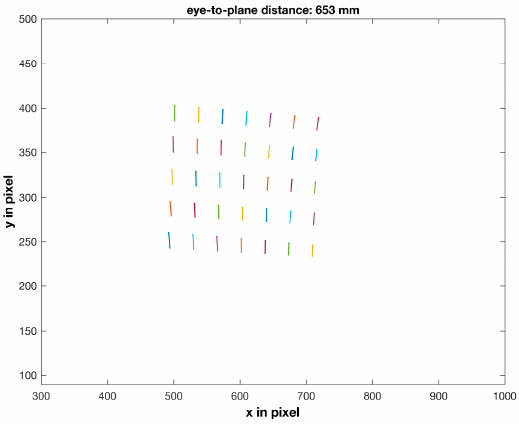
Figure A10. Map of disparities for a target plane placed at 653 mm from the observer.